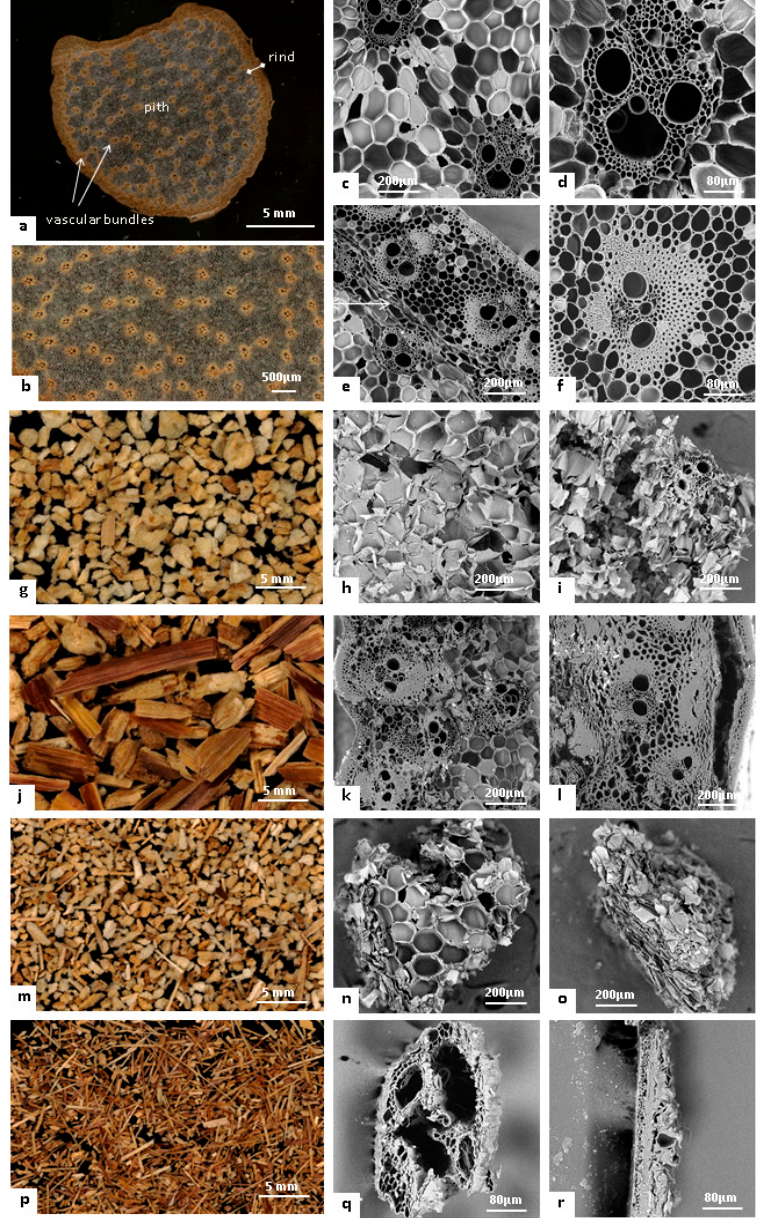
Figure 2. Visualization of maize stem internode structure ( a – f ) and fractions isolated: CF-2 ( g – i ), CF-1 ( j – l ), FF-1-A ( m – o ) and FF-1-B ( p – r ). a , b : Optical microscopy of maize internode cross-section; ( g , j , m , p ): optical microscopy of isolated fractions CF-2, CF-1, FF-1-A, and FF-1-B, respectively;